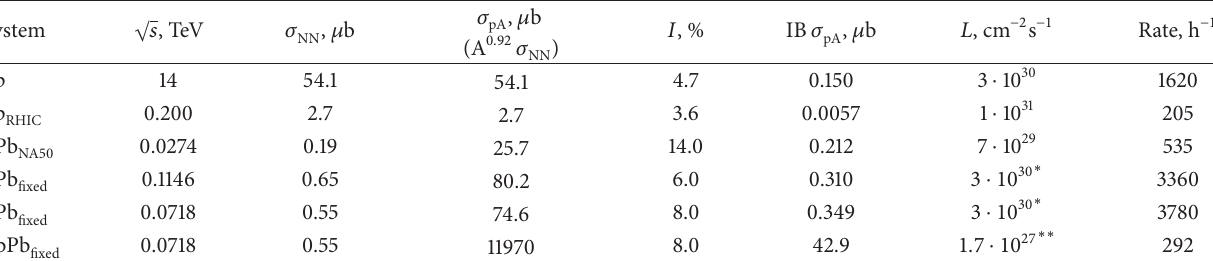
Table 1: Luminosity, cross sections ( 𝑥 𝐹 > 0 ), and counting